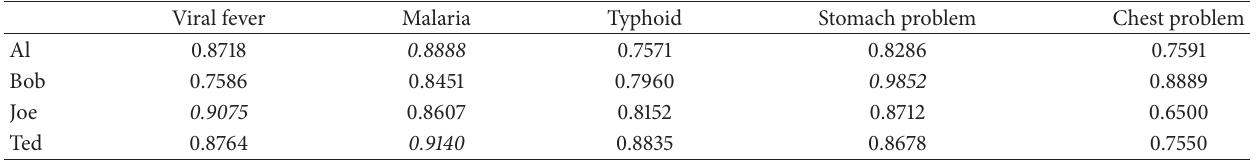
Table 4: Values of 𝜌 for each patient to the considered set of possible diagnoses. DHFS 2